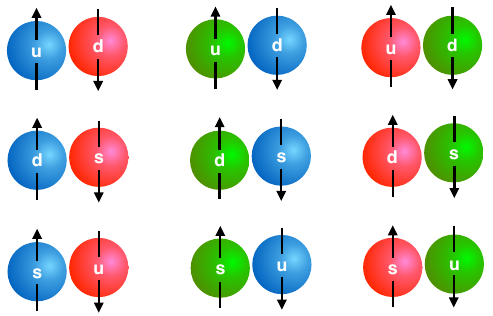
Figure 1. Schematic illustration of the different pairing combinations in the CFL phase. Quarks forming Cooper pairs have opposite charges and spins, and the presence of an MF reinforces the pairing (see